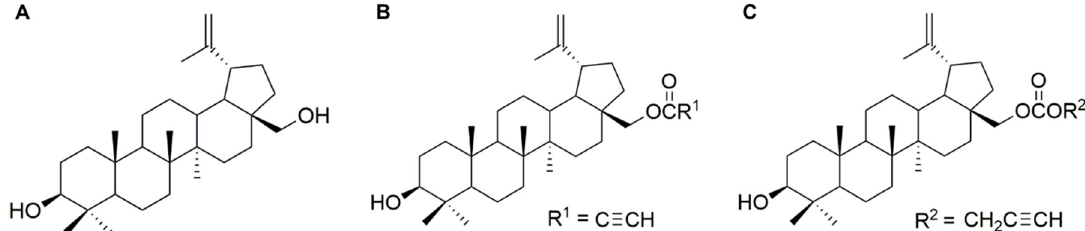
Figure 1. Chemical structure of betulin (Bet) and its acetylenic synthetic derivatives (ASBDs). ( A ) Structure of Bet, ( B ) 28- O -propynoylbetulin (EB5) and ( C ) 28- O -propargyloxycarbonylbetulin (EB25/1).